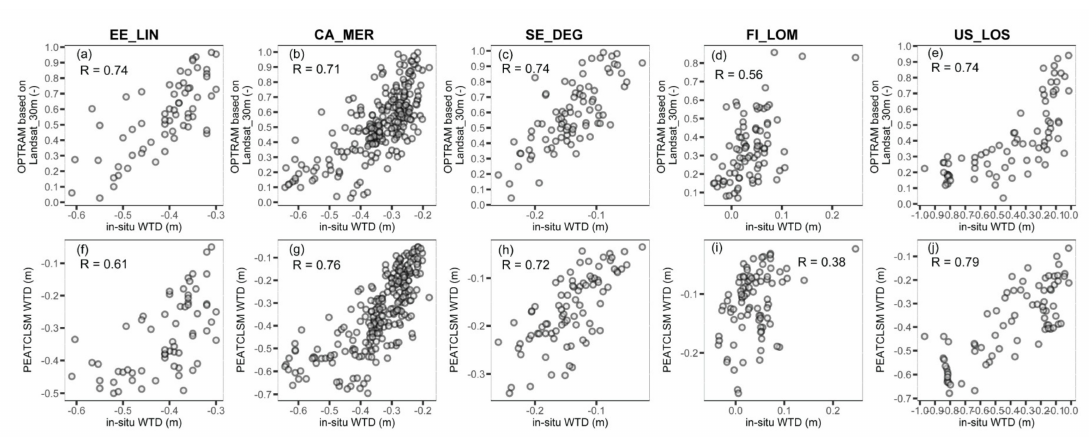
Figure 7. Scatterplots of (panels a–e ) in situ water table depth (WTD) and OPTRAM based on Landsat_30m ‘best pixel’, and (panels f–j ) in situ WTD and PEATCLSM WTD taken for the same days as for OPTRAM based on Landsat_30m and in situ WTD. The abbreviations of peatlands are given